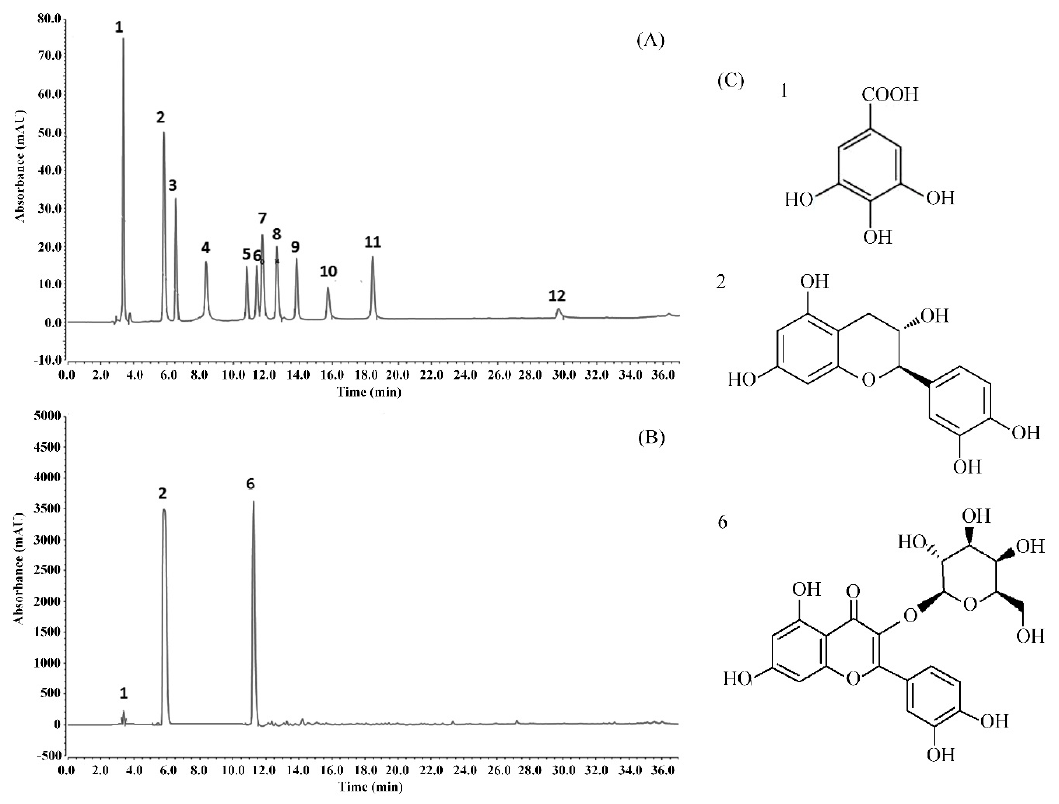
Figure 6. Analysis of the constituents of WPPs determined by HPLC. ( A ) standard chromatogram; ( B ) WPPs chromatograms; ( C ) molecular formulas of the WPPs. 1: gallic acid; 2: catechin; 3: puerarin; 4: gallocatechin gallate; 5: rutin; 6: hyperoside; 7: epicatechin gallate; 8: dihydroquercetin; 9: quercetin; 10: myricetin; 11: thiosulfonate; 12: bata-rhamnetin.